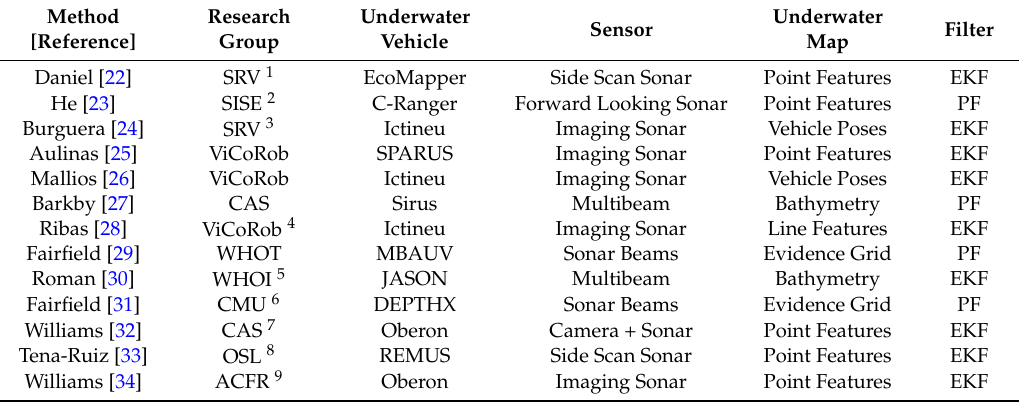
Table 2. The summary of state of the art underwater SLAM